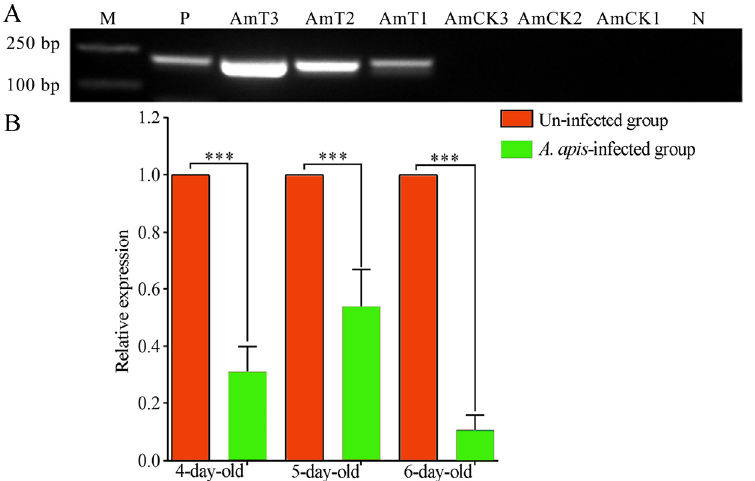
Figure 2. PCR validation and expression detection of ame-miR-34 in the guts of A. mellifera larvae inoculated with A. apis . ( A ) PCR validation of A. apis infection of A. mellifera larvae. Lane M: DNA marker; lane P, pure spores of A. apis (positive control). Lane N, sterile water (negative control); ( B ) RT-qPCR detection of host ame-miR-34 during A. apis infection, data were presented as mean SD and subjected to Student’s t -test, ns: p > 0.05, ***: p <